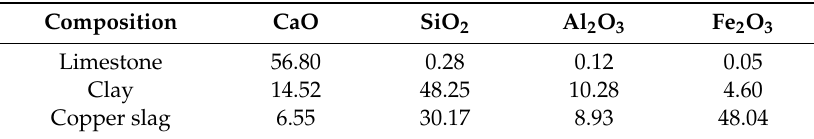
Table 1. Chemical composition of the raw materials (wt